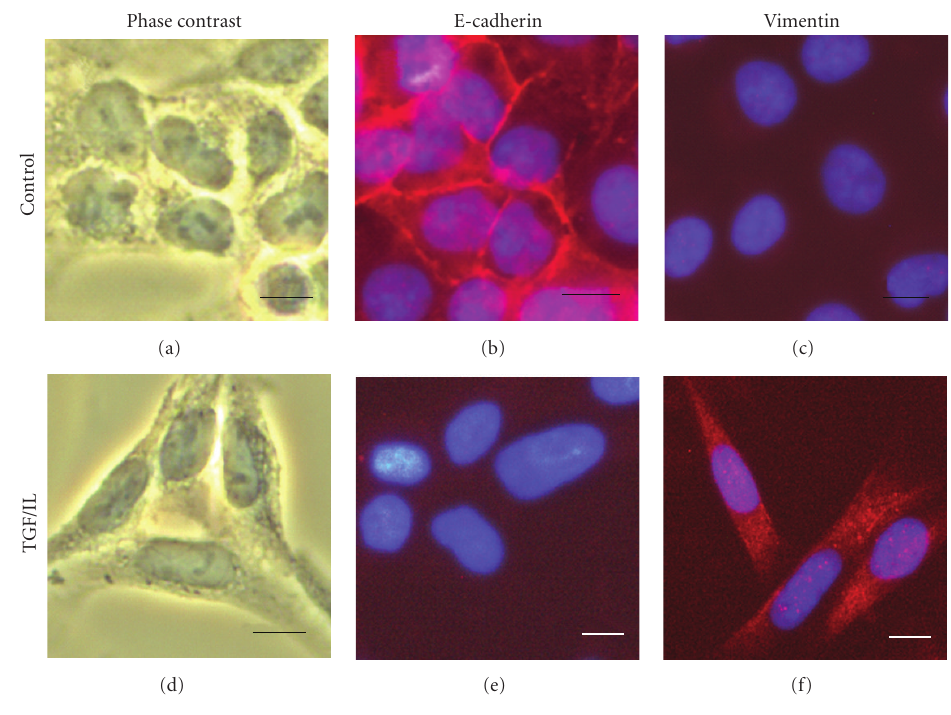
Figure 2: Combination treatment with TGF- β 1 and IL-1 β of A549 cells induces mesenchymal-like phenoptype. A549 cells following overnight serum starvation were treated with 10ng/mL each of TGF- β 1 and IL-1 β for 24 hours. Following which time, the cells were fixed, permeabilized, and stained with antibody against E-cadherin ( (b) and (e)) and vimentin ( (c) and (f) ) and nuclei were counterstained using 4 (cid:3) ,6-diamidino-2-phenylindole. Cells in (a) and (d) were photographed in a phase-contrast microscope. Scale bar: 10 μ